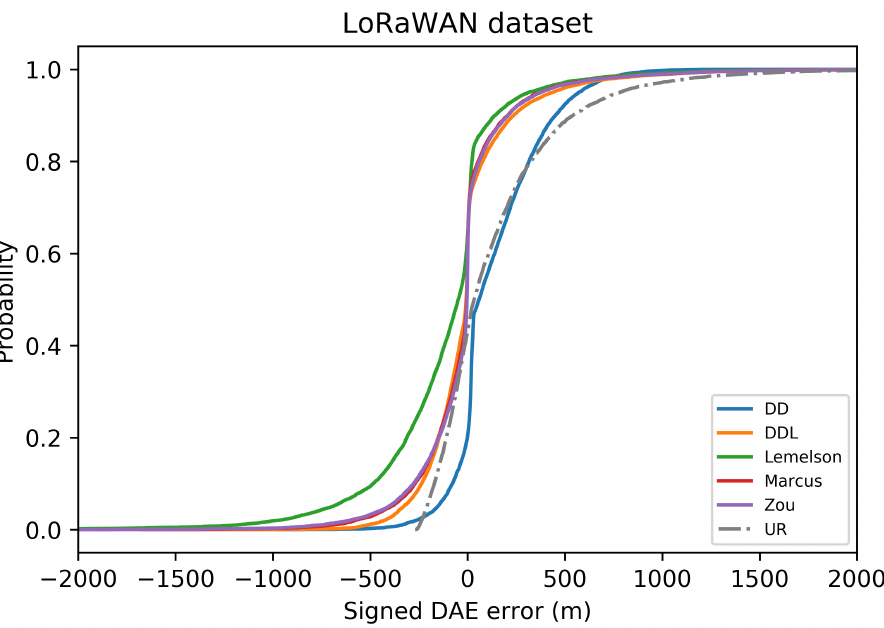
Figure 11. The Cumulative Distribution Function (CDF) of the signed DAE error (in meters) for all studied methods and one baseline, in the validation set of the LoRaWAN dataset. Negative values correspond to DAE overestimating the error (“ground-truth position inside the DAE circle”), while positive values correspond to DAE underestimating the error (“ground-truth position outside the DAE circle”).